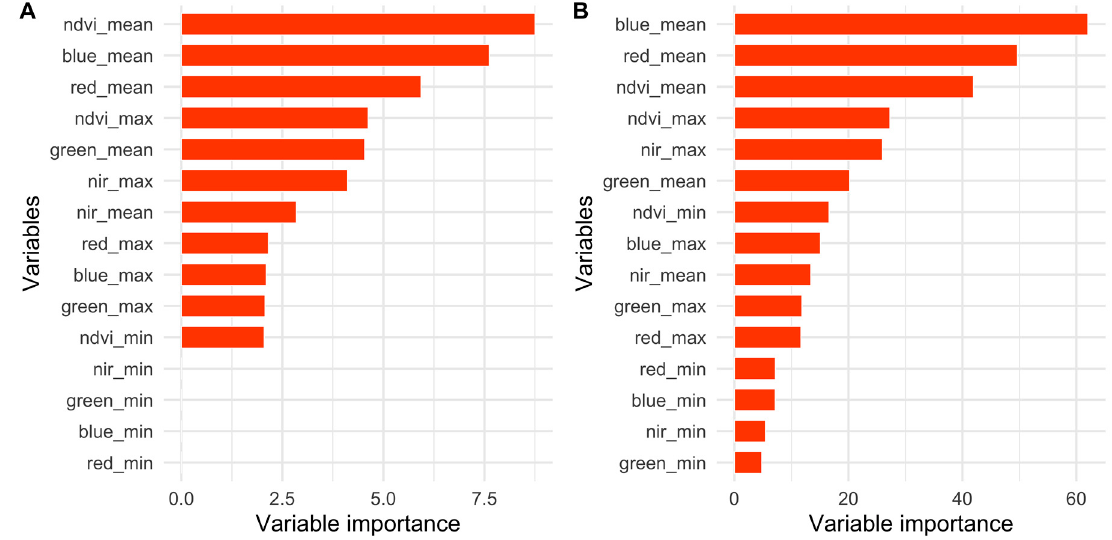
Figure 6. Relative importance of predictor spectral variables related to flowering when fine resolution imagery was used versus when fine-level imagery was combined with coarser resolution imagery. ( A ) Using PS only highlights NDVI as the top contributor. ( B ) PS, along with L8 and S2-1B, highlights the blue band as the top contributor.